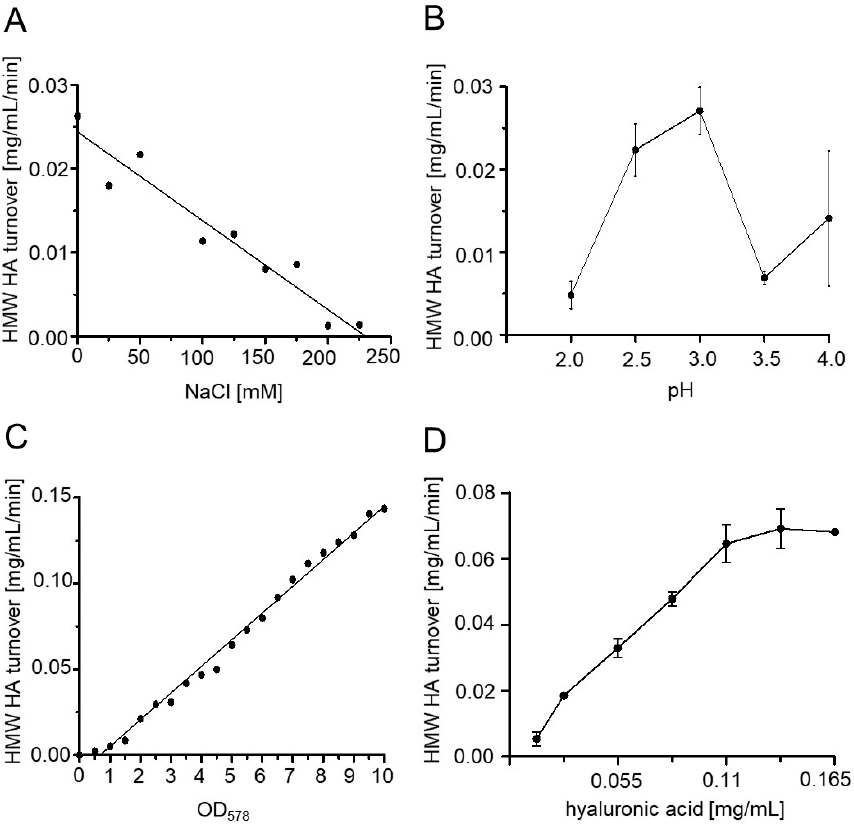
Figure 8. Improving the assay conditions for maximum Hyal1 activity. Whole cell activity measurements of cells displaying Hyal1 were performed. Cells were harvested after 16 h of induction and OD 578 was set to 10 or as indicated, followed by incubation at 37 °C for one minute under different conditions. Enzyme activity as HMW HA turnover in mg/mL/min dependent on NaCl concentration ( A ) and pH value ( B ), optical cell density at 578 nm ( C ) and HA substrate concentration ( D ). Residual HMW HA was detected using the Stains-all assay. Mean values ± SD are given (n = 3).